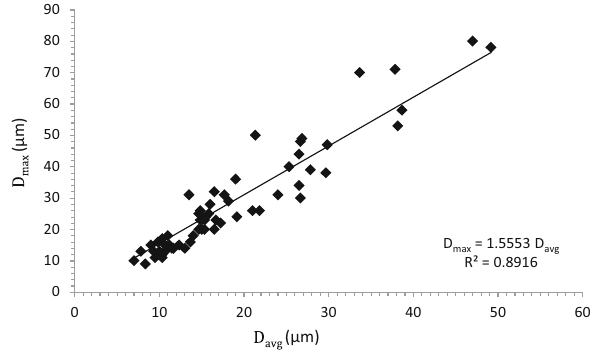
Fig. 7 The plot of average aperture width ( D avg ) versus maximum aperture width ( D max ) for Raniganj coals showing a strong linear correlation between them